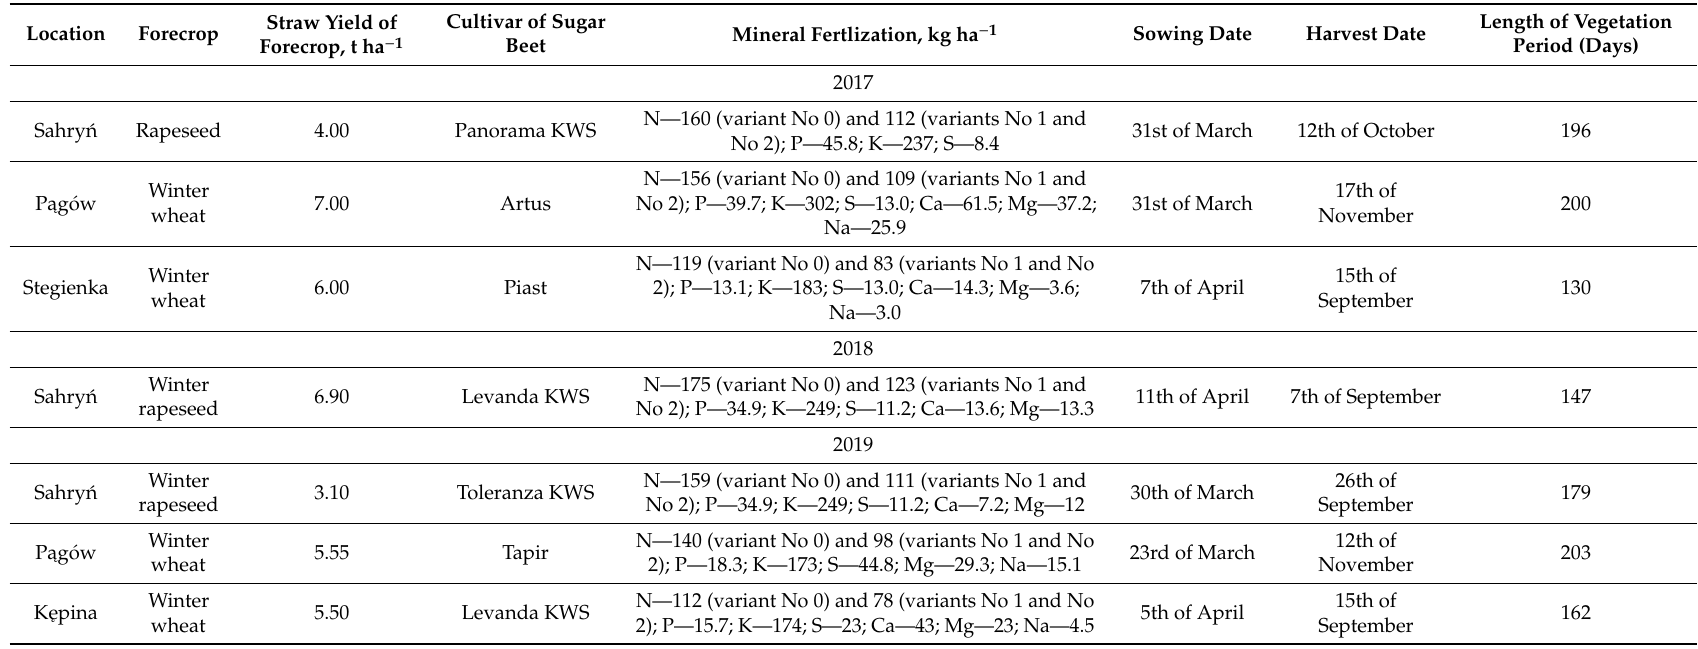
Table 3. Characteristics of sugar beet production technology in the experiment